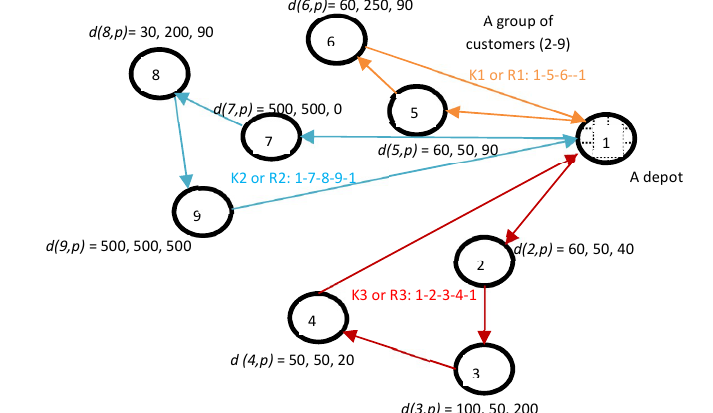
Fig. 3. A distribution network for fuel